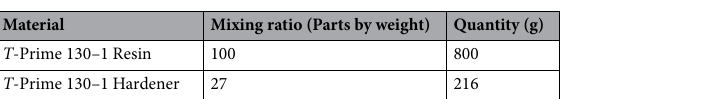
Table 4. Resin and hardener mixing ratios.